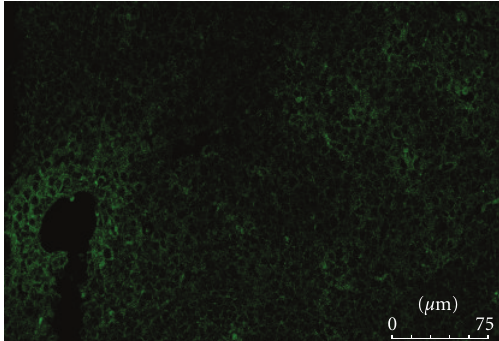
Figure 10: Immunofluorescence staining for CD25 in lymph node medulla after 4-week inhalation.